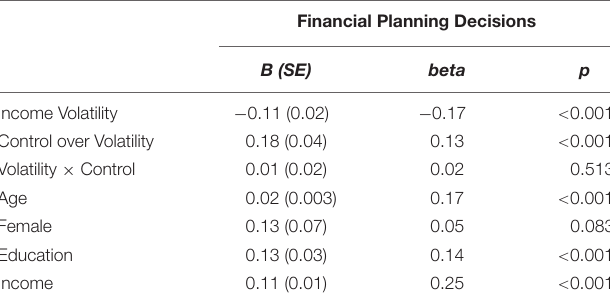
TABLE 3 | Regression estimates for link of income volatility and control over volatility with the combined financial planning decisions, controlling demographic